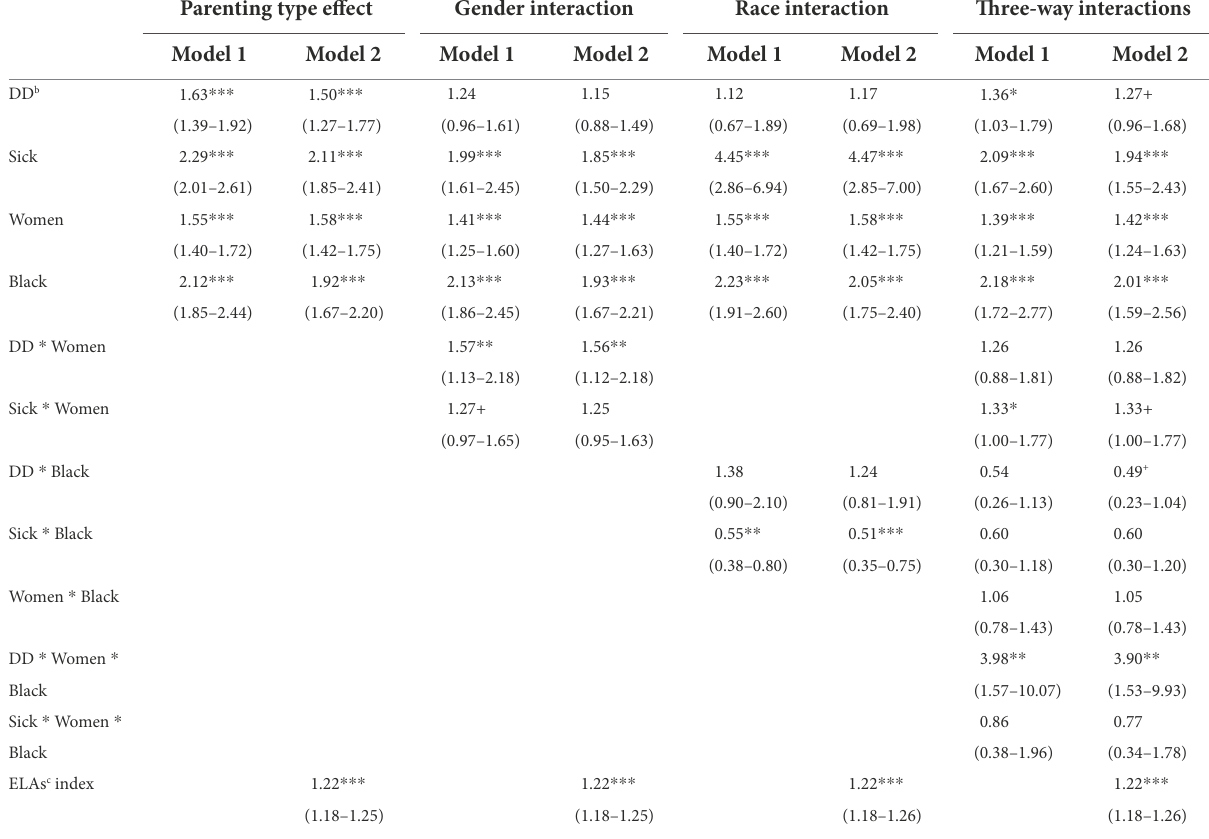
TABLE 4 Estimates of the effects of parenting type and interactions on functional limitations (n = 7,425) a